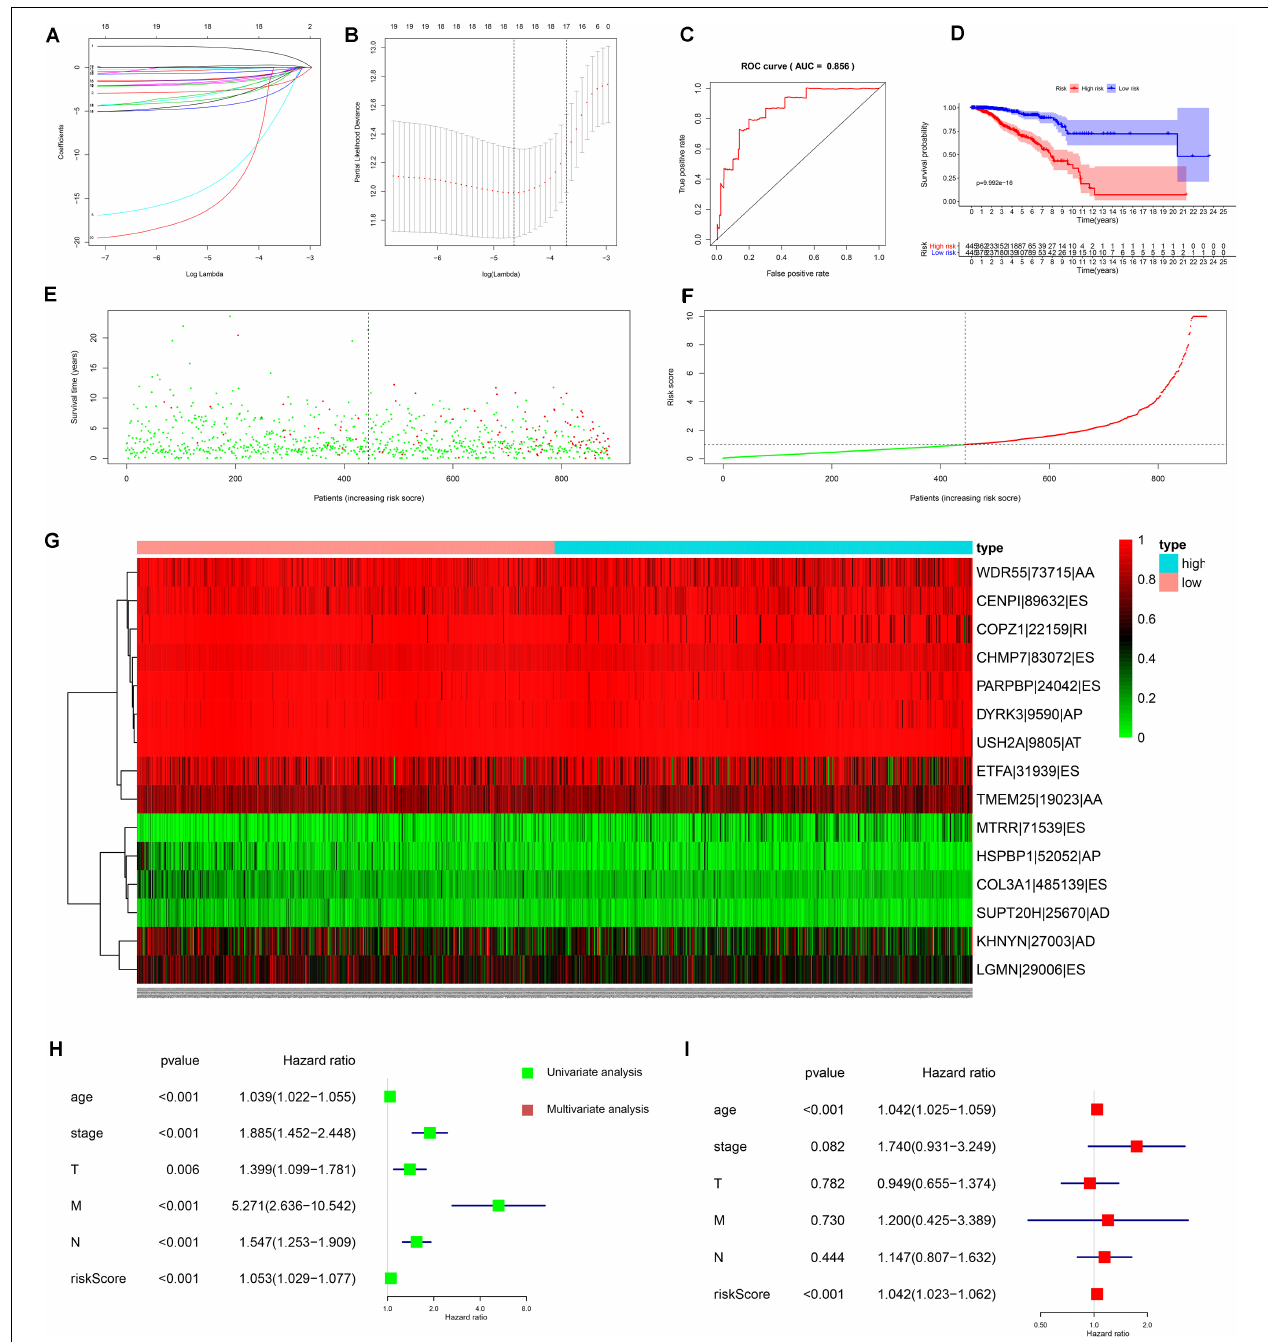
FIGURE 4 | Construction and results of independent prognostic model. (A) The Lasso plot which determine of the number of overall-survival-associated splicing events in survival analysis by Lasso regression. (B) The Lambda plot which determine of the number of overall-survival-associated splicing events in survival analysis by Lasso regression. (C) The receiver operator characteristic curve (ROC) of survival analysis; the area under the ROC curve is 0.856. (D) The Kaplan–Meier plotter of the survival analysis in which low-risk patients (purple curve) is more likely to live longer than high-risks patients (red curve). (E) The scatterplot of survival time and the risk score of both low-risk patients (green points) and high-risk patients (red points). (F) The risk plot of both low-risk patients (green points) and high-risk patients (red points). (G) The heat map of 15 final-selected overall-survival-associated splicing events’ expression from the TCGA dataset. AA, alternate acceptor; AD, alternate donor; AP, alternate promoter; AT, alternate terminator; ES, exon skip; ME, mutually exclusive exons; RI, retained intron. (H) The forest plot of univariate Cox regression analysis. (I) The forest plot of multivariate Cox regression analysis.